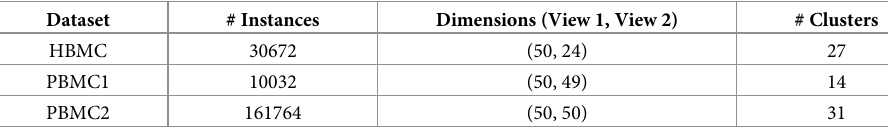
Table 1. Summary of the three multi-view datasets after pre-processing.